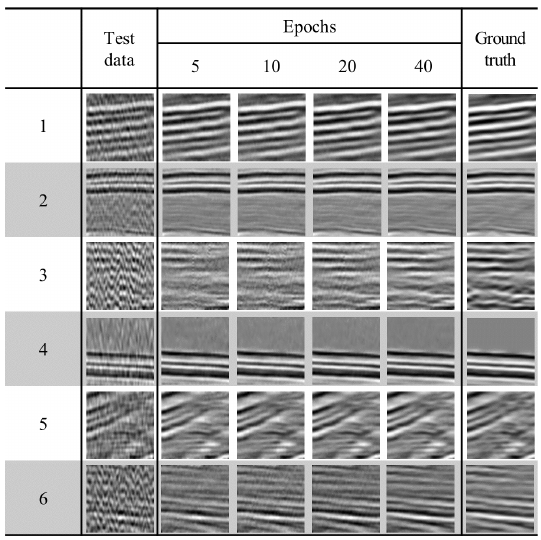
Figure 7. Test data, ground truth, and denoised results after apply- ing the DnCNN models trained using training dataset